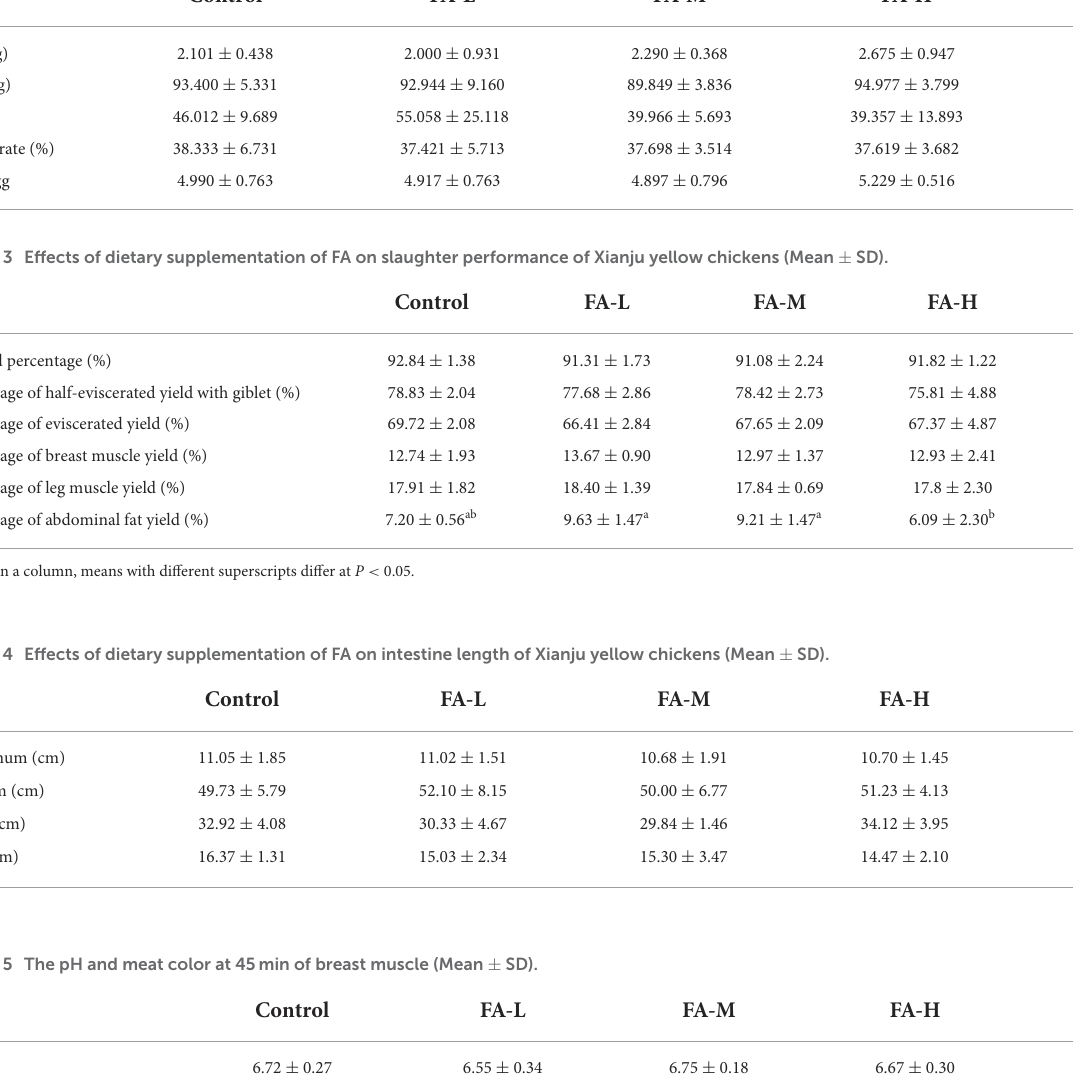
TABLE 2 Effects of dietary supplementation of FA on growth performance of Xianju yellow chickens (Mean ± SD). Items